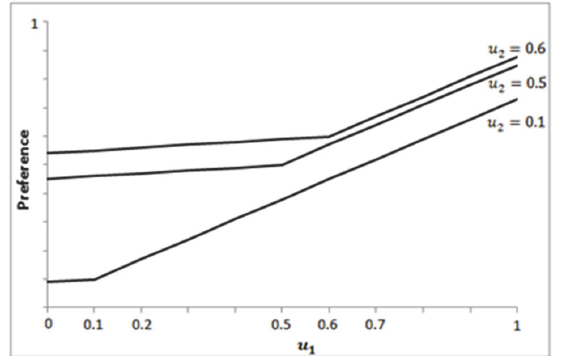
Fig. 5. Choquet integral result for the example violating weak difference independence condition.